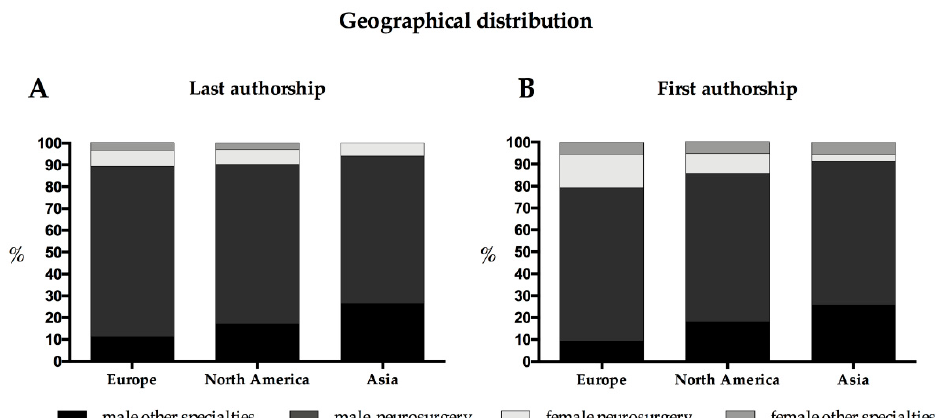
Figure 3. Geographical distribution of the authors: ( A ): last authorship; ( B ): first authorship. With respect to affiliation to a neurosurgical department, neither ratios for the first nor last authorships differed significantly comparing female with male authors (each for Europe, North America and